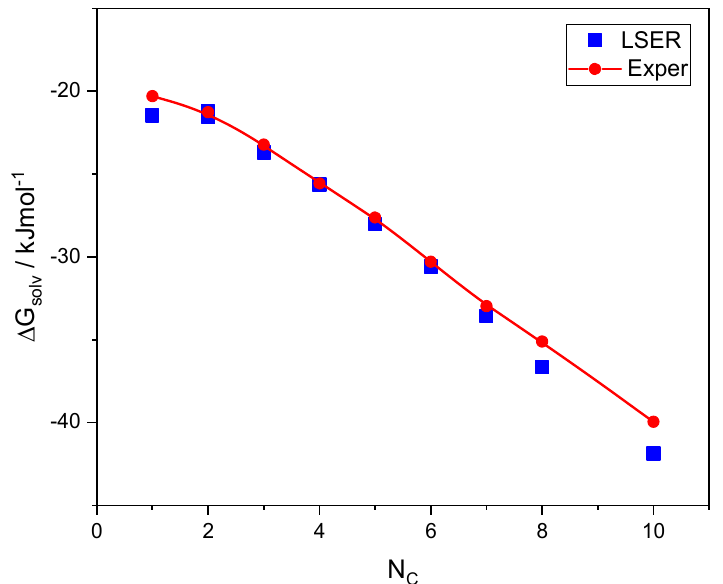
Figure 2. Comparison of the experimental [49] solvation free energies of 1-alkanols with the corresponding LSER calculations as a function of carbon atoms in the molecule.